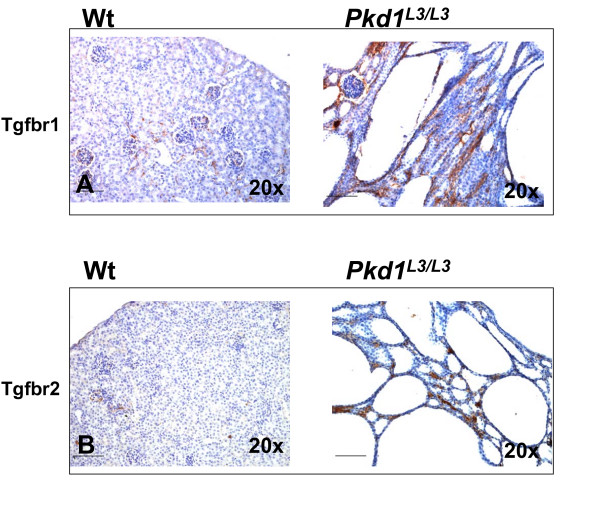
Elevated expression of TGFβR1 and TGFβR2 in Pkd1L3/L3 and control mice at PNW 3.5. Immunohistochemistry of kidney of Pkd1L3/L3 and control mice at PNW 3.5, using monoclonal antibody to TGF-β receptor subtypes 1 and 2, visualized with diaminobenzidine (DAB). Representative images for Tgfbr1 (A) and Tgfbr2 (B) are shown. Scale bar shows 100 μm.